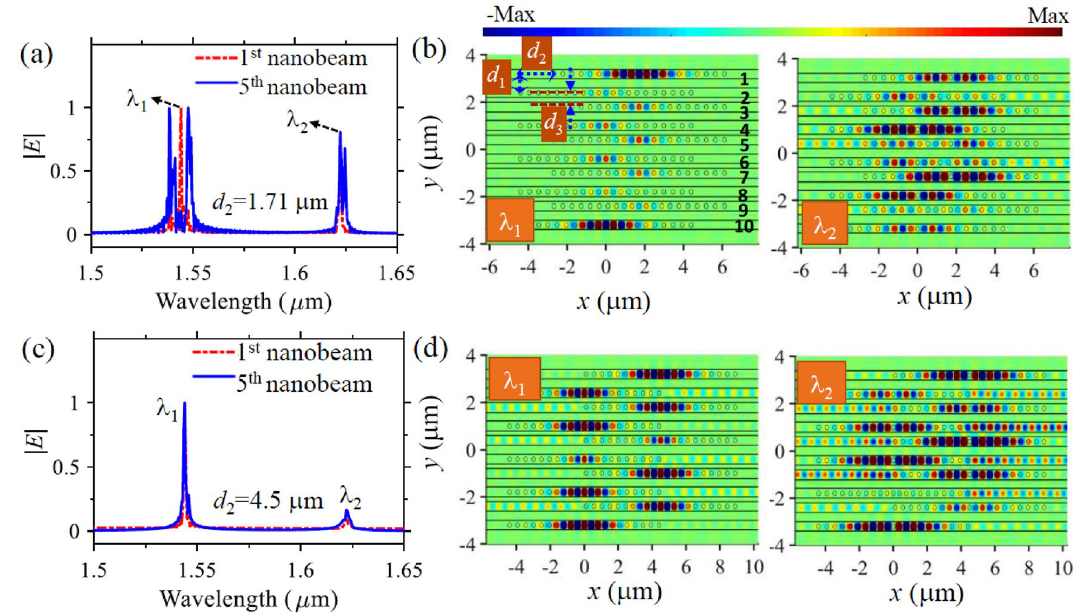
Figure 5. Tailoring TESs with different axial shift of the SSH nanobeams. ( a ) Spectra of the edge and middle nanobeams of the SSH structure when d 2 = 1.71 µ m , showing a merged peak at (cid:31) 2 = 1.624 µ m and suggesting the edge mode not being allowed at this wavelength. ( b ) The corresponding electric field distribution | E | at the spectra peak wavelengths (cid:31) 1 (left) and (cid:31) 2 (right), respectively. ( c ) Spectra of the edge and middle nanobeams of the SSH structure when d 2 = 4.5 µ m , showing merged peaks at both (cid:31) 1 = 1.546 µ m and (cid:31) 2 = 1.624 µ m and indicating non generation any edge mode. ( d ) The corresponding field distribution H z at the two wavelengths. The other geometrical parameters of the nanobeams are the same as those in Fig.